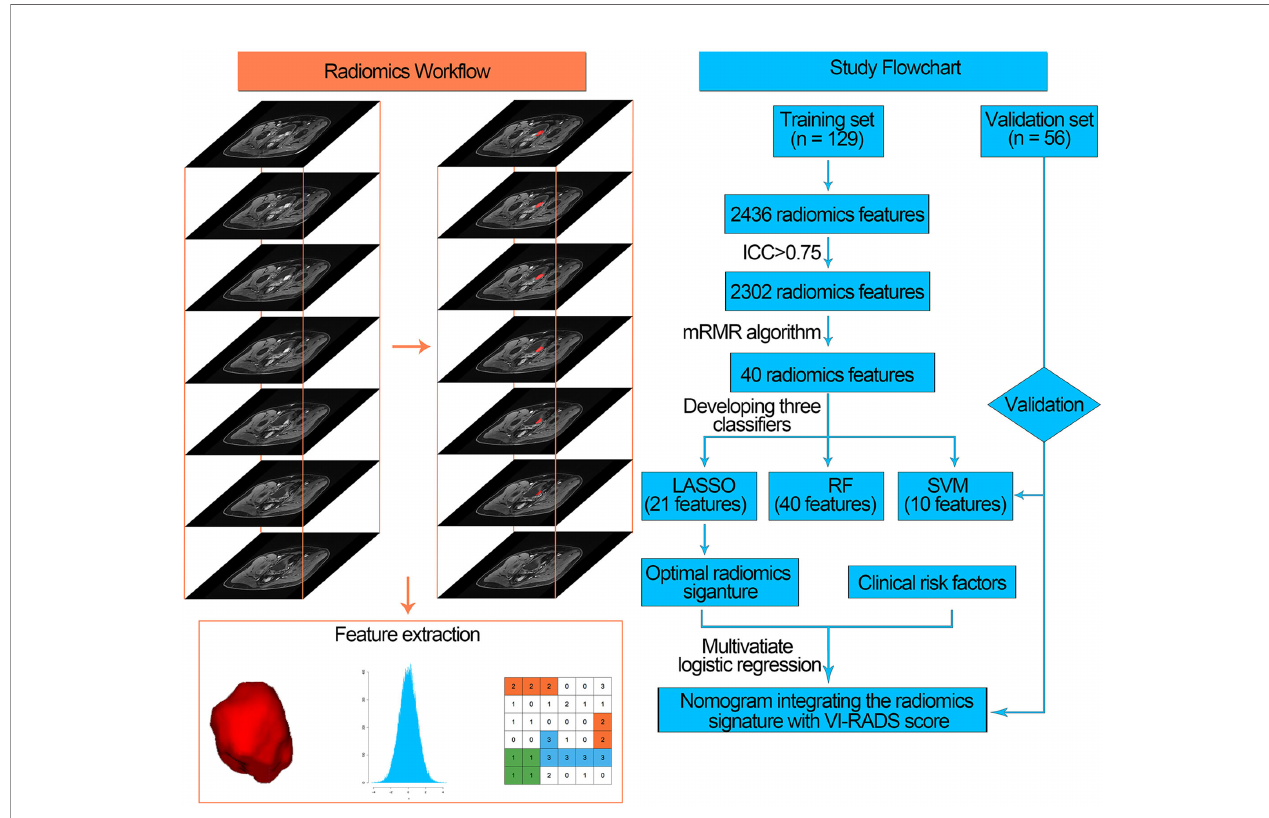
FIGURE 2 | Radiomics work fl ow (left) and study fl owchart (right) of our study. mRMR, minimum redundancy maximum relevance, ICC, intra- and interclass correlation coef fi cient; LASSO, least absolute shrinkage and selection operator; RF, random forest; SVM, support vector machine; VI-RADS, Vesical Imaging- Reporting and Data